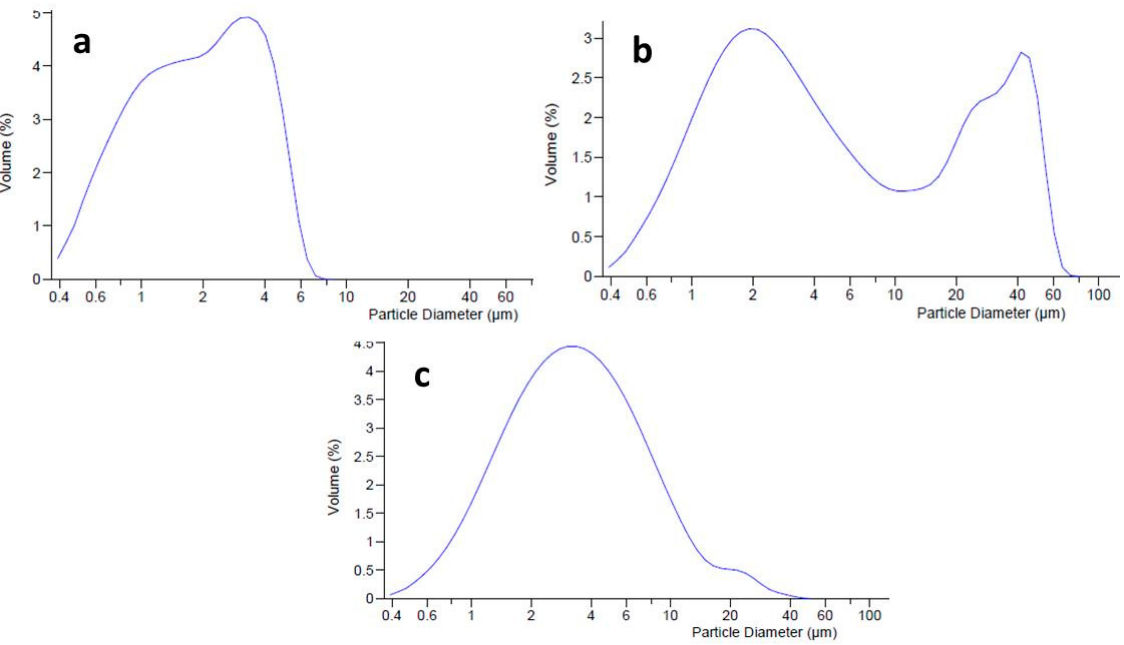
Figure 3. Dimensional distribution of blank emulgel ( a ), MTE emulgel ( b ), and MTE-mp emulgel ( c ).